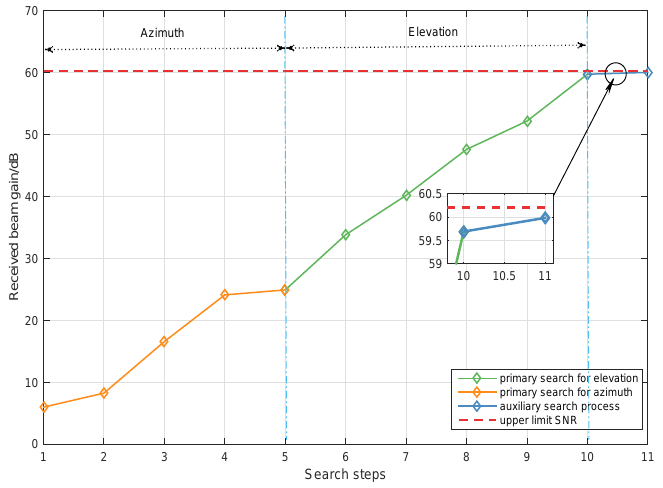
Figure 5. Beamforming gain during 3D BSL-VT beam training process when N = M = 32, α = 4.